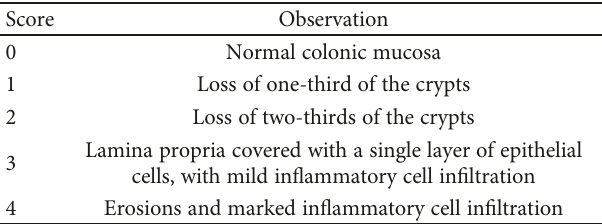
Table 2: Criteria for assessment of microscopic rectal damage.